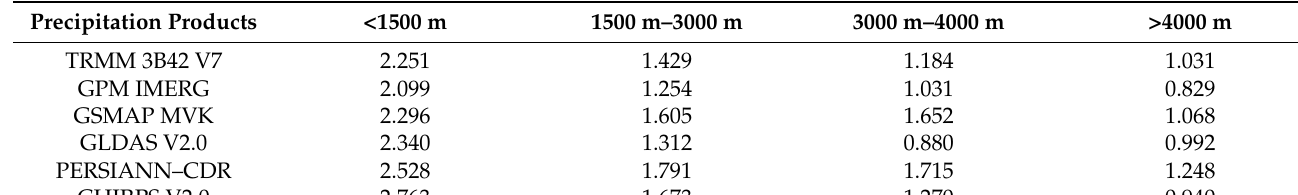
Table 8. RMSE between different elevation intervals.